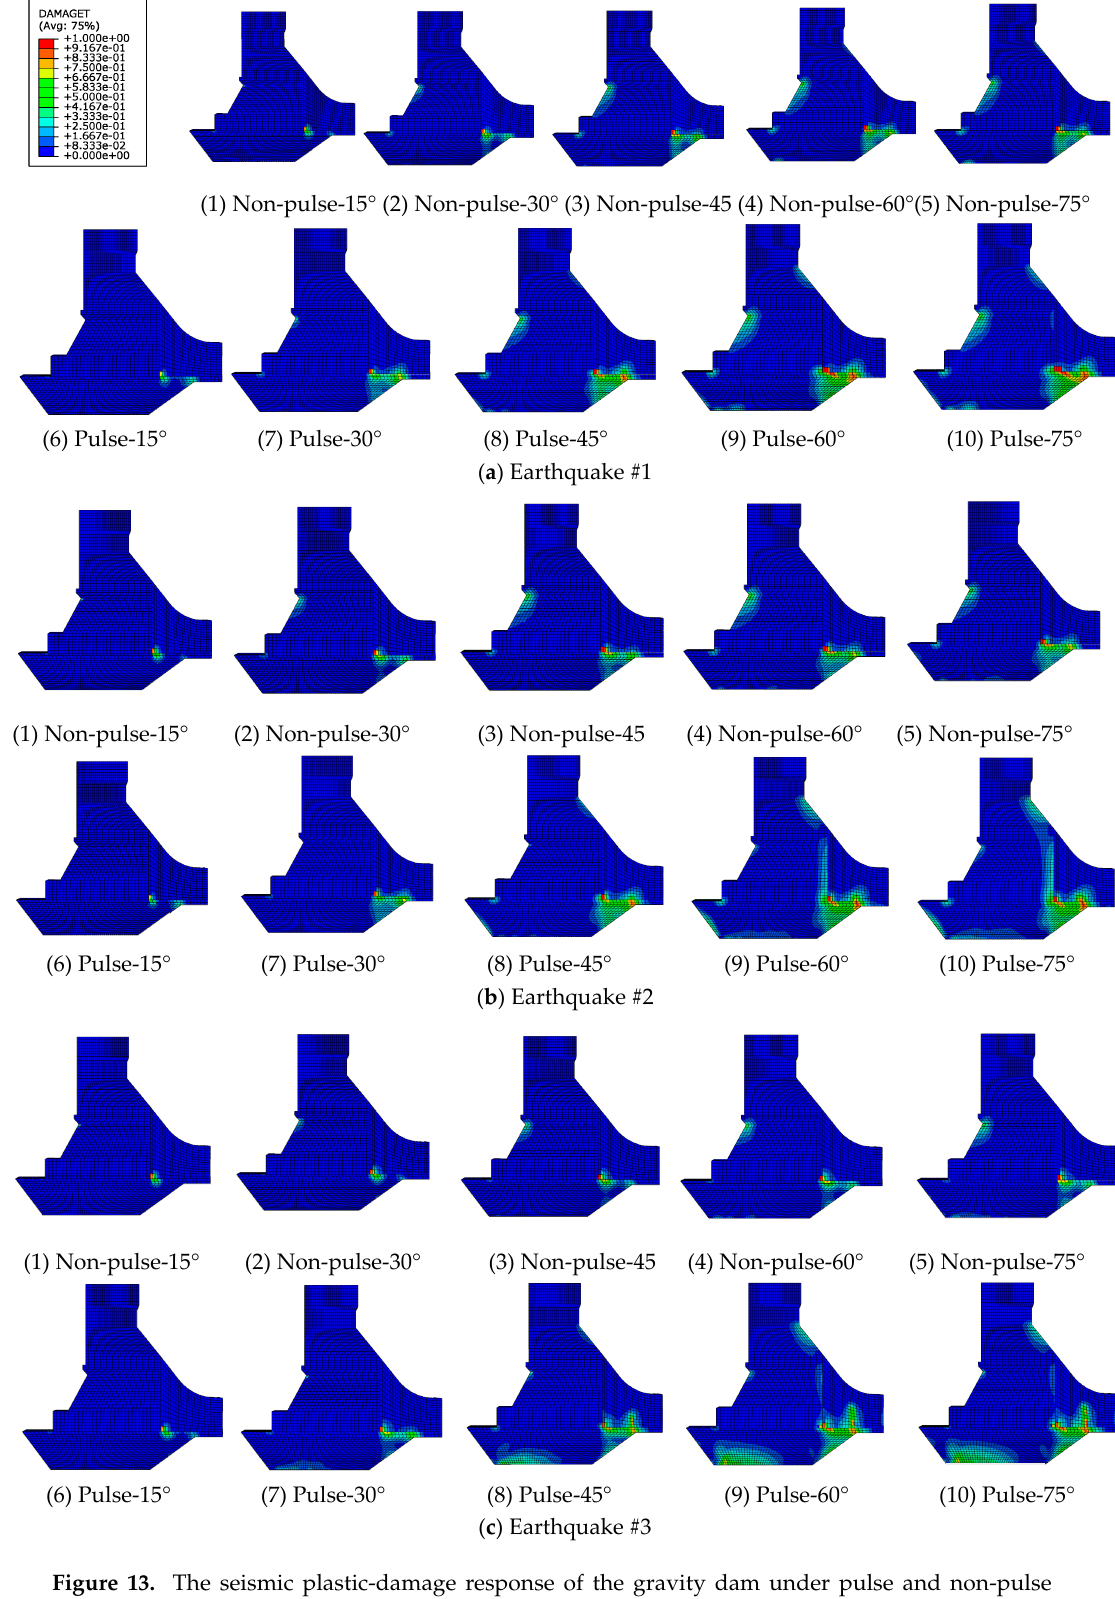
Figure 13. The seismic plastic-damage response of the gravity dam under pulse and non-pulse ground motions.